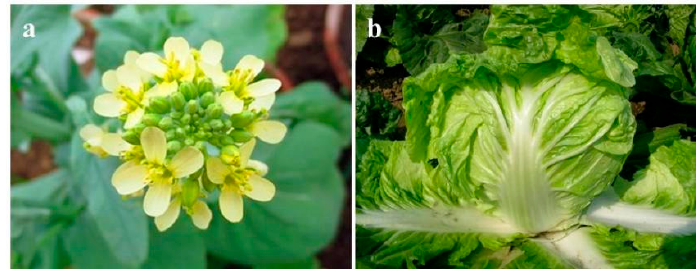
Figure 1. Wild-type ‘FT’ plant. ( a ) floral organ; ( b ) leafy head.